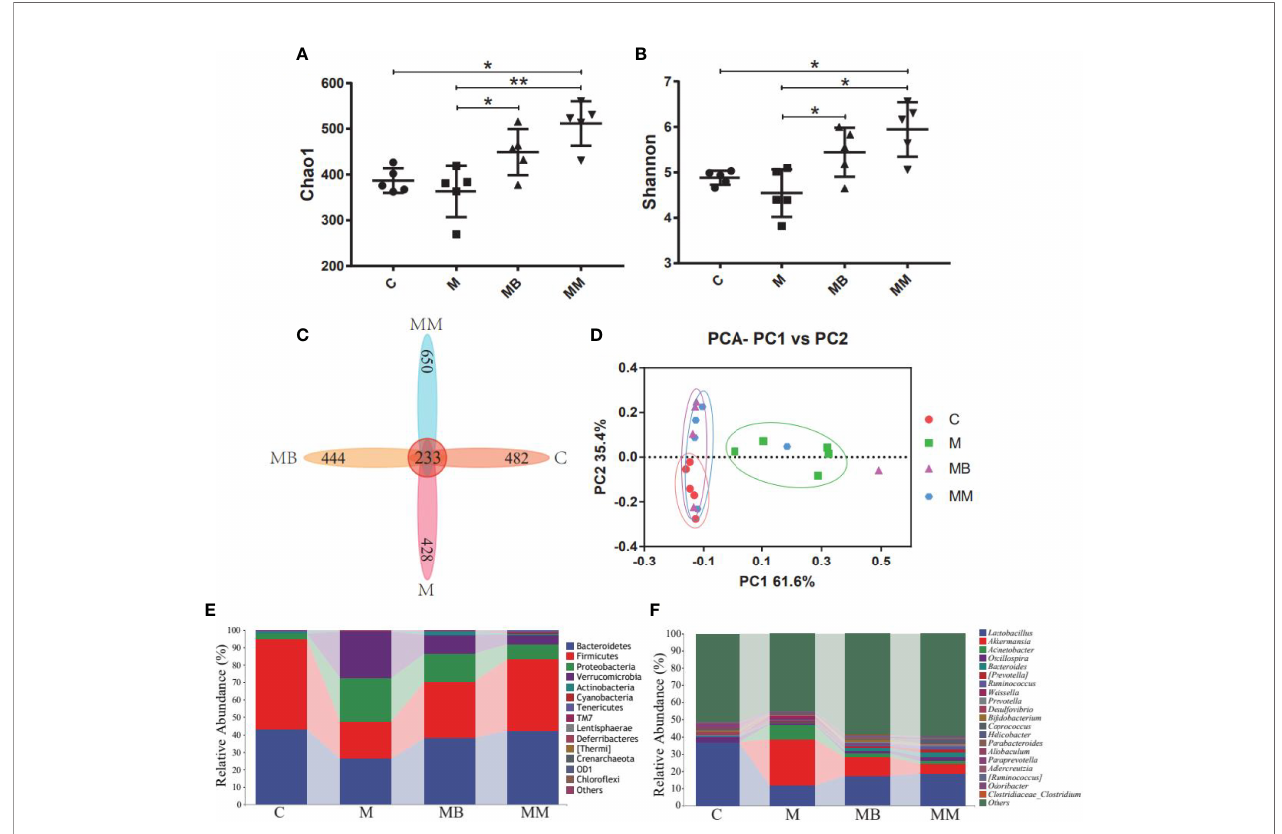
FIGURE 3 | BefA protein on intestinal microbiota of the T1DM model. (A) the Chao1 index. (B) the Shannon index. (C) Venn map representation of OTUs. (D) PCA of b diversity index. (E) Microbial composition at the phylum level. (F) Microbial composition at the genus level. Data are presented as means ± SD. One way repeated-measures ANOVA with Tukey ’ s test for multiple comparisons ( A, B , respectively); * p < 0.05, ** p <